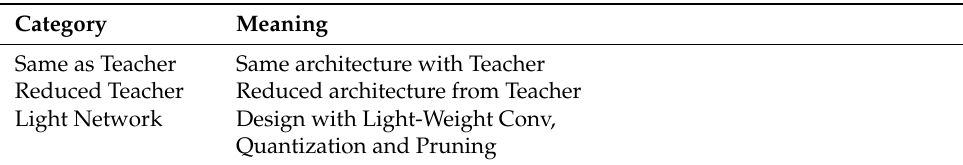
Table 4. KD Classification according to Teacher–Student